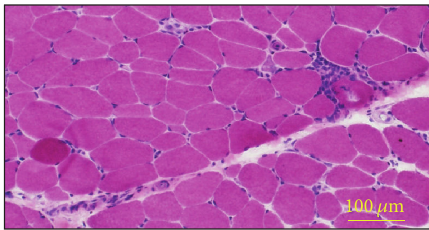
Figure 3: Hematoxylin-Eosin (H&E) staining of the biceps brachii muscle. Muscle fiber necrosis and regeneration and mild inflamma- tory cell infiltration in the perivascular region of perimysium can be